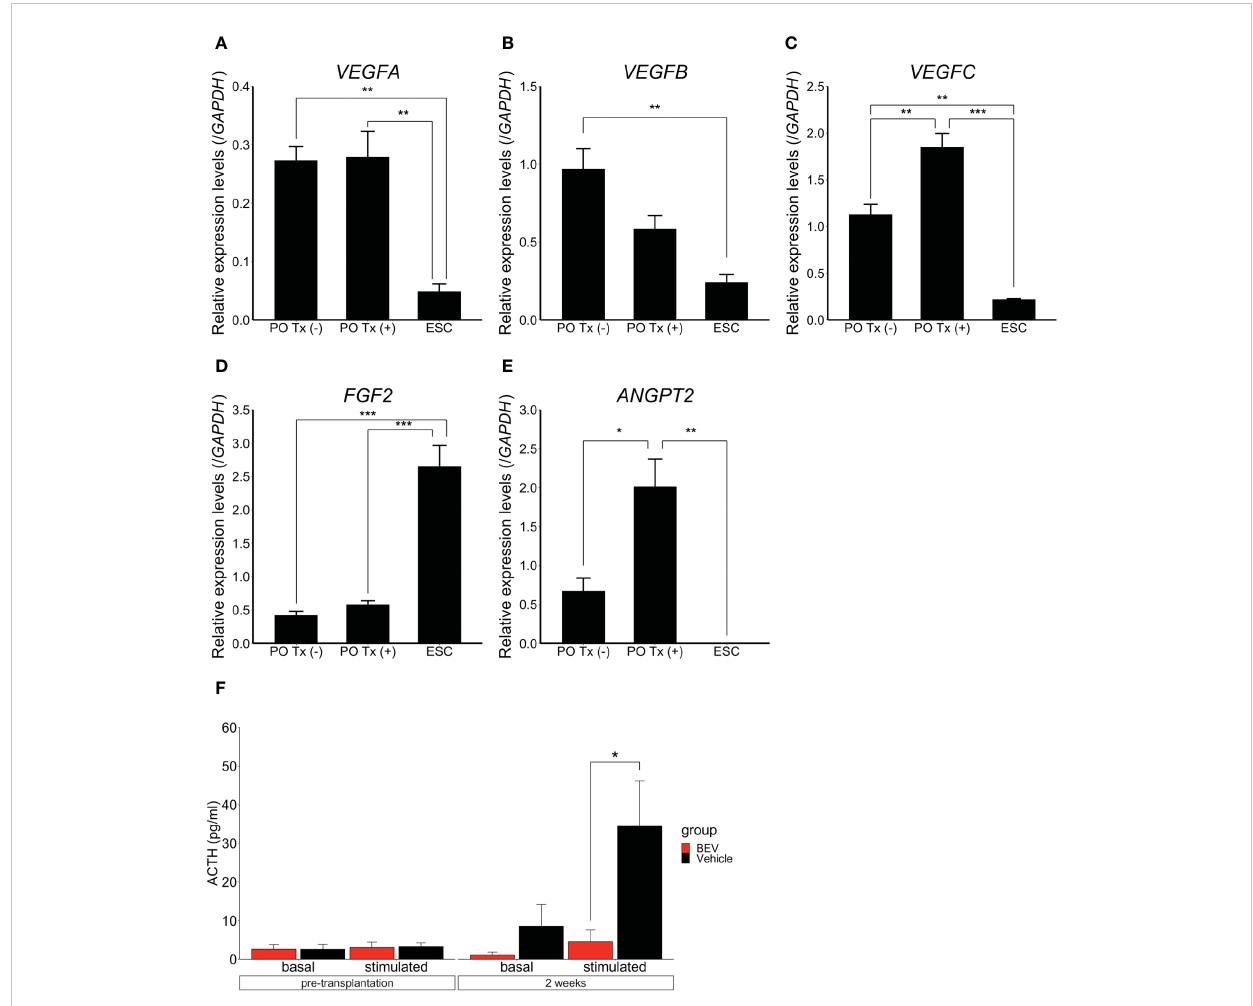
FIGURE 4 Expression and effects of angiogenic factors in hESC-derived POs All data presented as mean ± SEM. *p<0.05, **p<0.01, ***p<0.001. Quantitative PCR results, expression of VEGFA (A) , VEGFB (B) , VEGFC (C) , FGF2 (D) , and ANGPT2 (E) in POs without transplantation, transplanted POs ( “ with transplantation ” ), respectively PO Tx (-) and PO Tx (+), and undifferentiated ESC. Expression was normalized to that of GAPDH . PO Tx (-), n=3. PO Tx (+), n=3. ESC, n=3. Statistical assessment, one-way ANOVA with post hoc Tukey ’ s test. (F) Comparison of basal and CRH-stimulated serum ACTH levels with bevacizumab (BEV) or vehicle administration. BEV, n=9. Vehicle, n=9. Student ’ s t